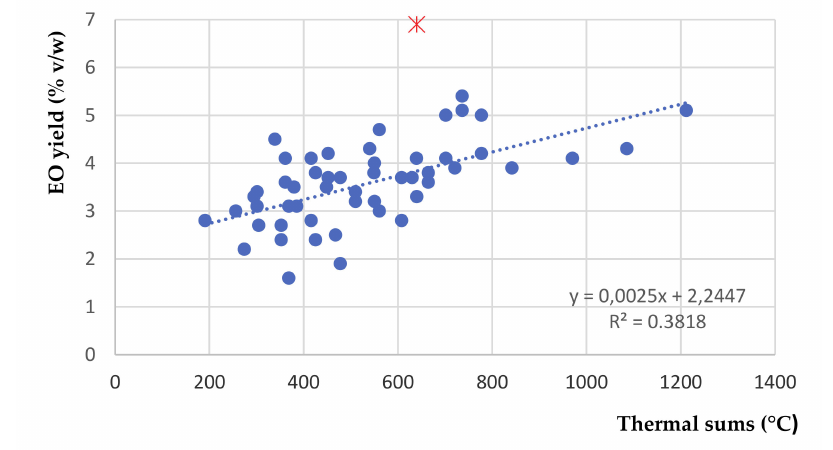
Figure 5. Scatterplot diagram of essential oil yields vs. thermal sums in a 3-year trial on Origanum heracleoticum in 3 Sicilian localities. n = 53. A red asterisk (*) marks an